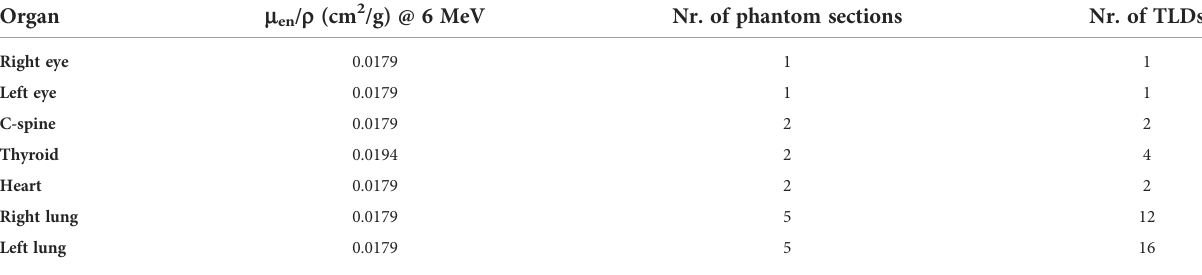
TABLE 4 Organ characteristics assessed in